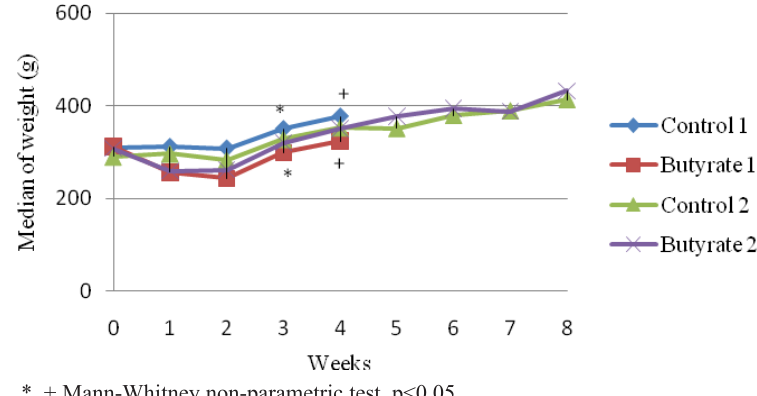
FIGURE 2 - Evolution of the weight of the